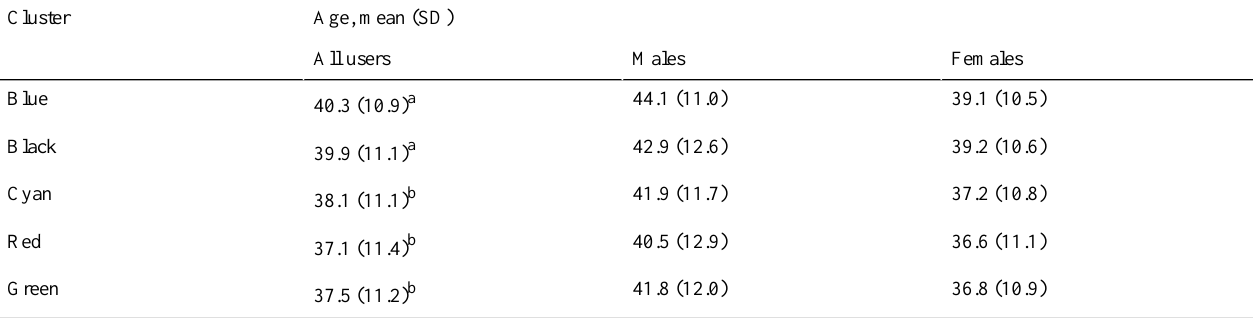
Table 2. Mean age of males and females in each cluster.